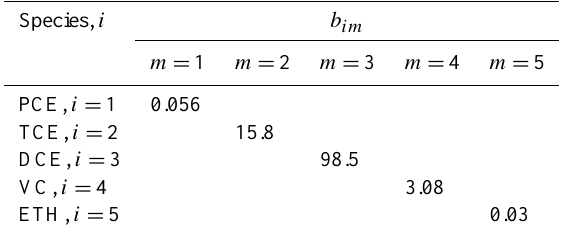
Table 10. Transport parameters used for example application in- volving the five-species dissolved chlorinated solvent problem used by BIOCHLOR.